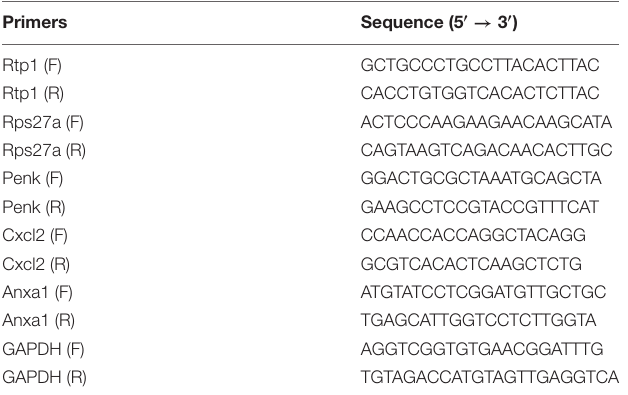
TABLE 1 | Primers used in this